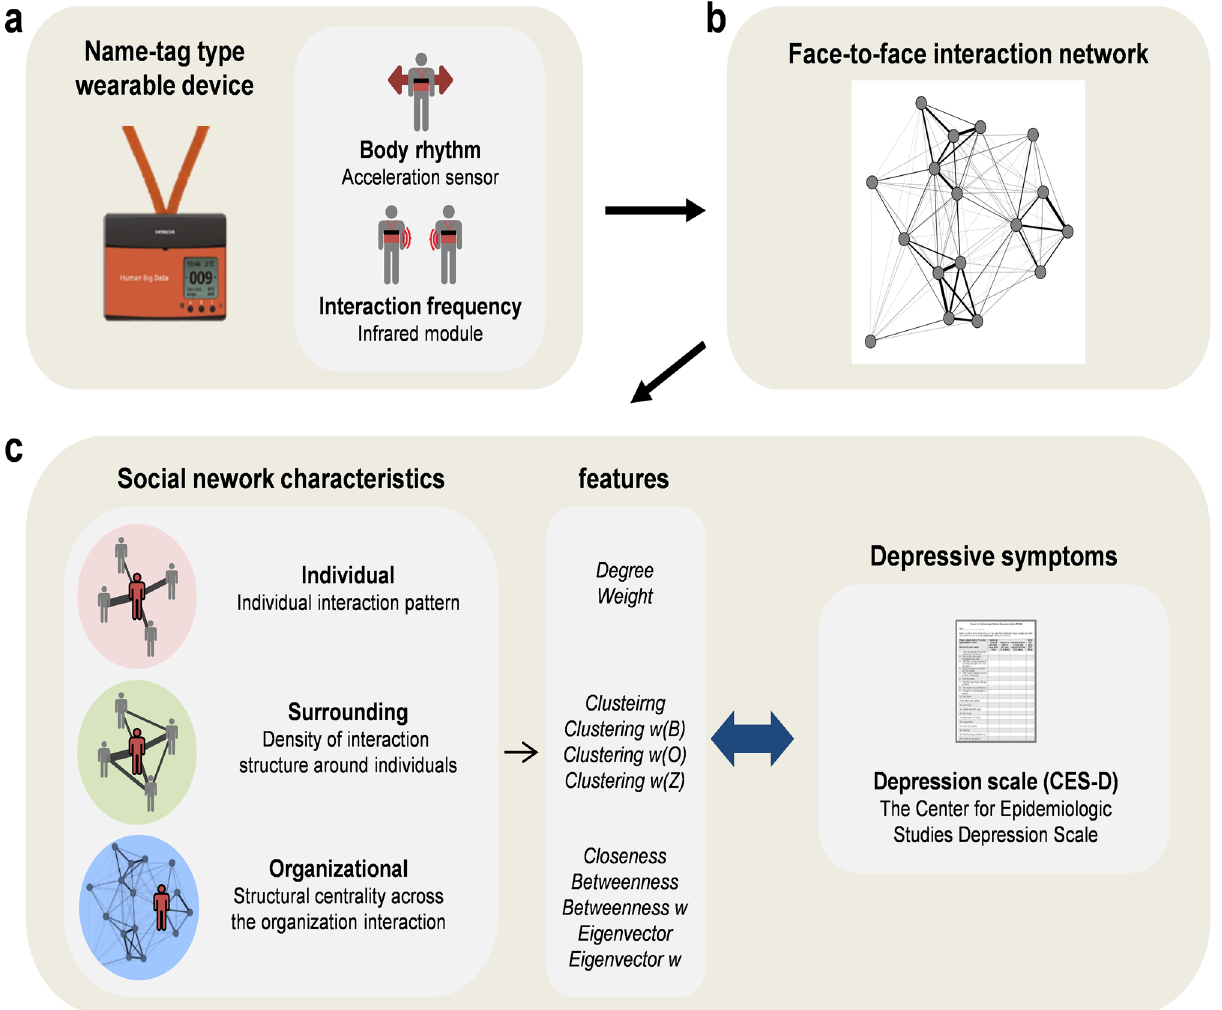
Figure 1. Analysis procedure. ( a ), A wearable name-tag-type device detected body movements and interactions. Body movements were measured from the zero cross count of the acceleration near the chest, and interactions were measured through infrared module detection with other devices. ( b ), The workplace’s face-to-face interaction network was constructed from the interaction information. The average number of interactions per day was used to weight each link. Body movements were used to estimate the degree of activity of each interaction and to compare the characteristics of networks composed of active and inactive interactions. ( c ), The social network characteristics extracted from various scales of the face-to-face interaction network were compared with the depressive symptoms assessed by the depression scale (CES-D). See “Methods” section for detailed description of social network characteristics and depressive